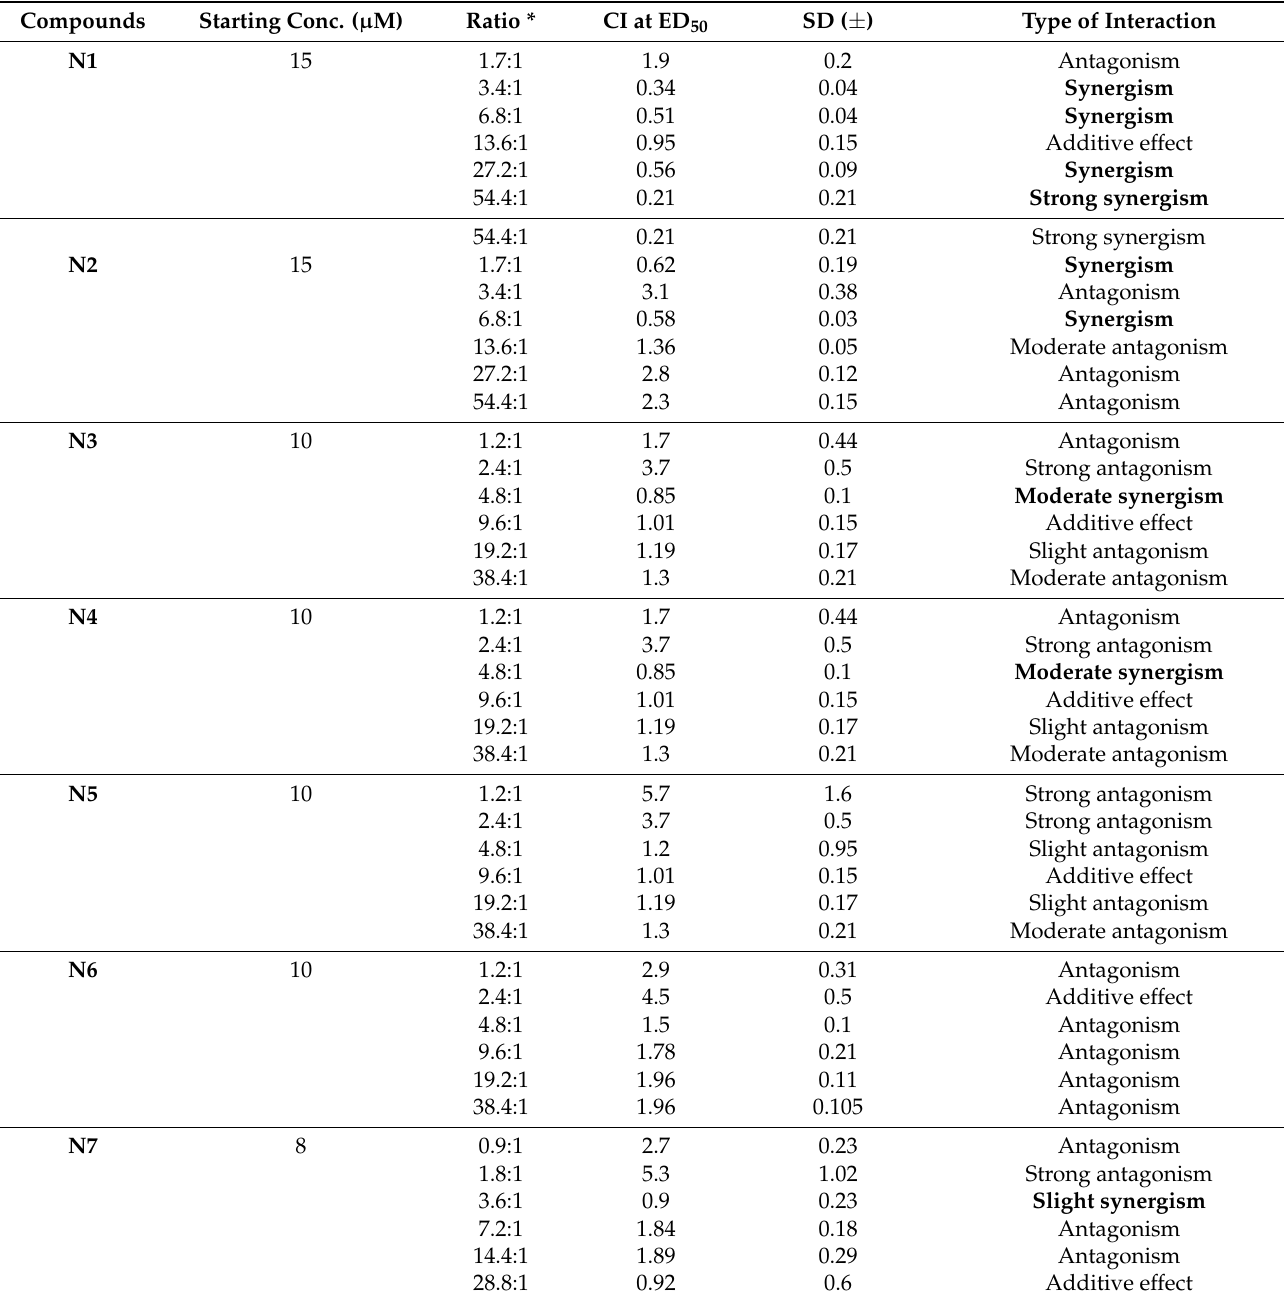
Table 6. Interaction of cyanoselenoesters with doxorubicin on MDR Colo 320 colon adenocarcinoma cells. Compounds Starting Conc. ( µ